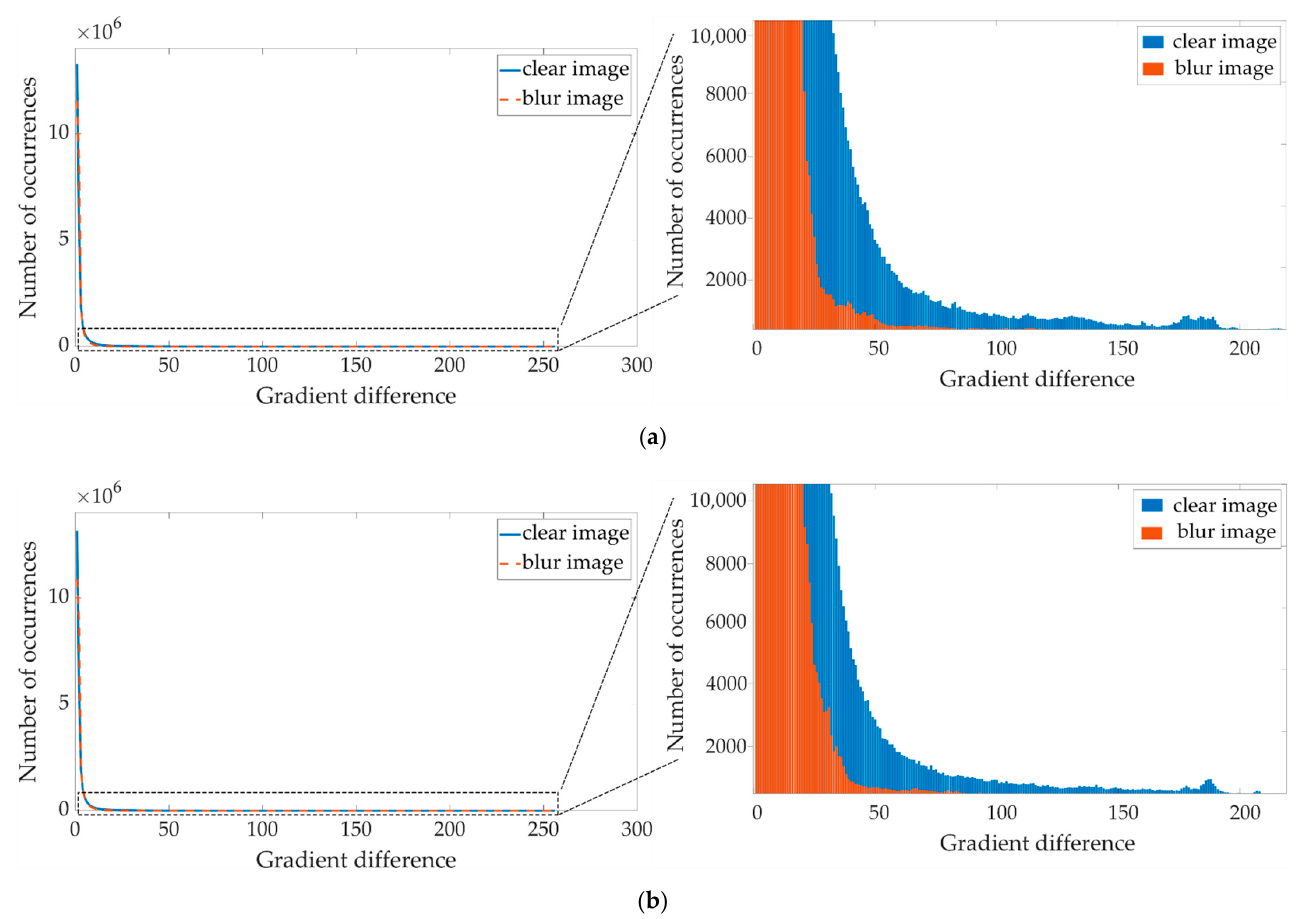
Figure 1. Gradient contrast map of infrared images before and after blurring: ( a ) row direction gradient contrast of clear and blurred images; ( b ) column direction gradient contrast of clear and blurred images.